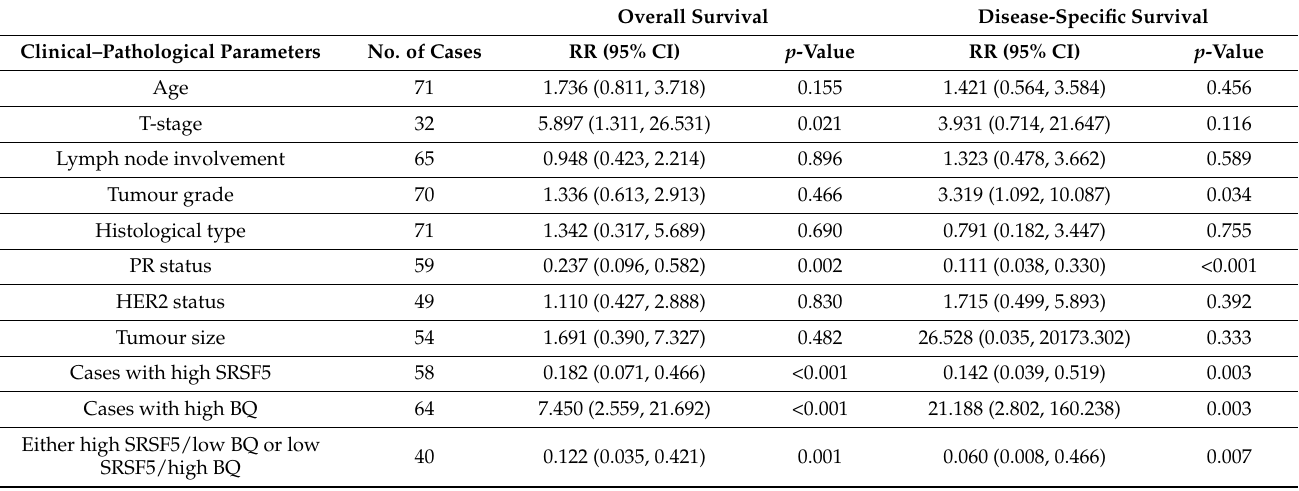
Figure 5. The clinical significance of SRSF5 in ER +ve breast cancer. ( A ) Expressions of SRSF5 and BQ in tumour tissues examined by immunohistochemistry. Representative images are shown. The scale bar represents 20 µ m. ( B ) The expressions of SRSF5 and BQ showed a negative correlation. Linear regression was performed to determine the relationship, and the Spearman coefficient was determined. Low expression of SRSF5 was associated with ( C ) tamoxifen (TAM) resistance, ( D ) local recurrence and ( E ) metastasis. Chi-square test was employed. Kaplan–Meier survival analysis showed that the cases of ER +ve breast cancer with low expression of SRSF5 had poorer outcomes of ( F ) overall and ( G ) disease-specific survival. Table 3. Univariate cox regression analysis of overall and disease-specific survival in ER +ve breast cancer.